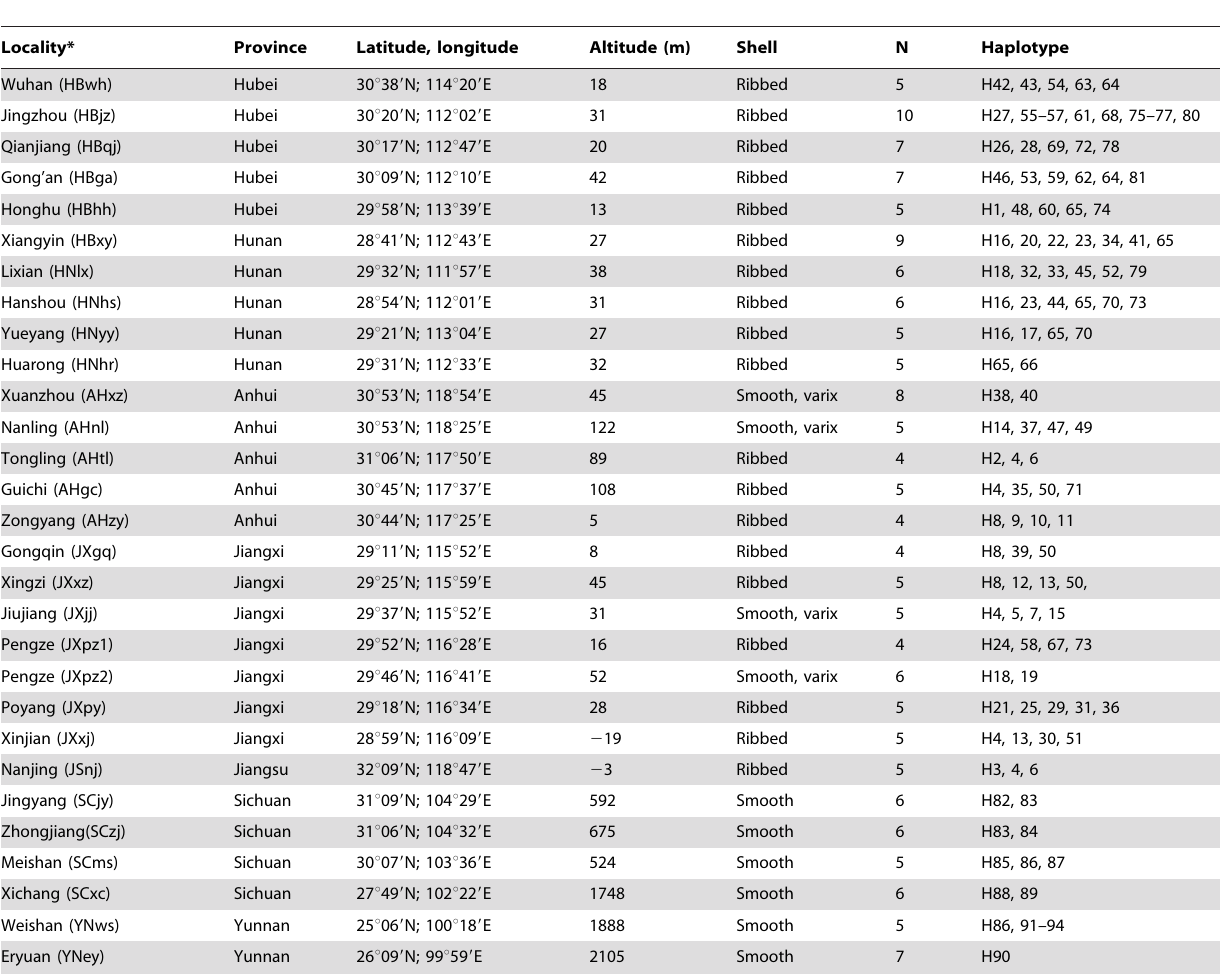
Table 1. List of population samples in the study, with collection data and haplotype information for Oncomelania hupensis ITS1– ITS2